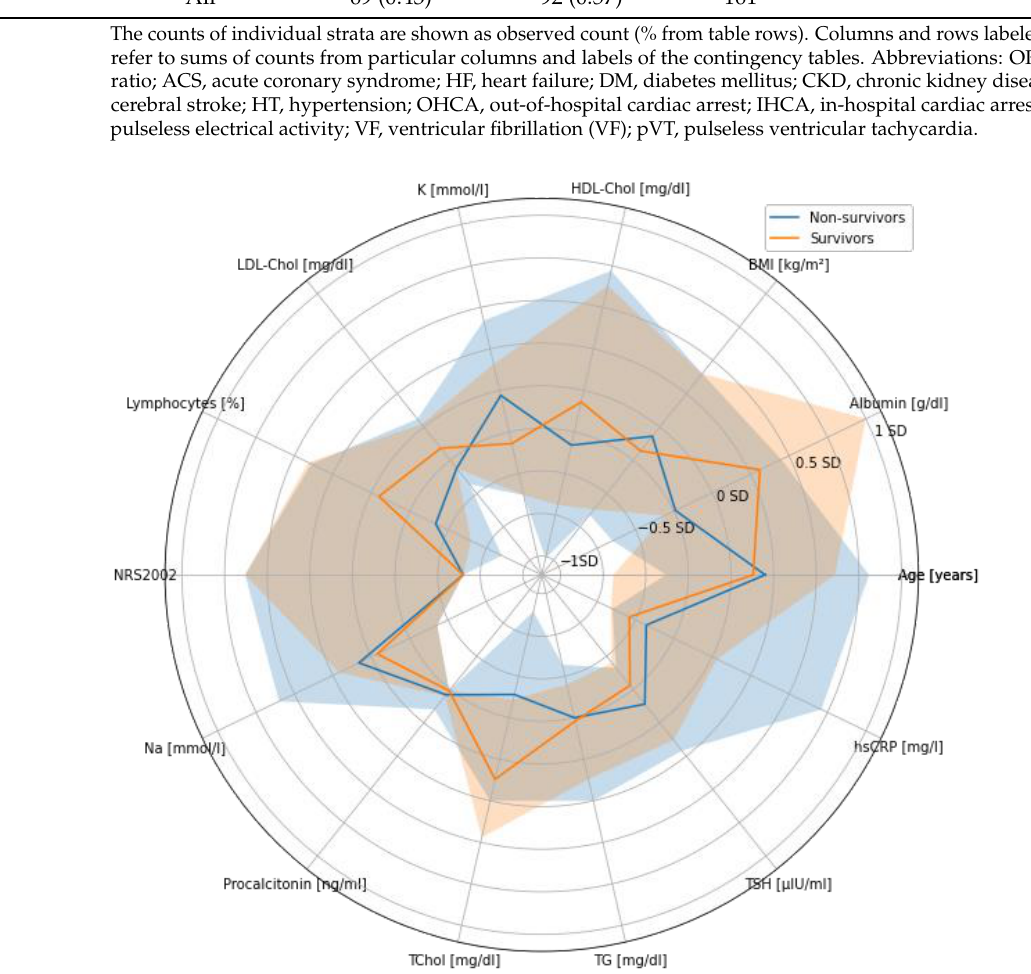
Figure 1. Radar plot of standardized values of selected quantitative parameters in the context of survival. Median values and 1st-to-3rd quartile range are marked with lines and colored areas, respectively. Abbreviations: BMI, body mass index; HDL, high-density lipoprotein; K, potassium; LDL, low-density lipoprotein; NRS 2002, Nutritional Risk score; Na, sodium; PCT, procalcitonin; TC, total cholesterol; TG, triglycerides; TSH, thyroid-stimulating hormone; hsCRP, high-sensitivity C- reactive protein.